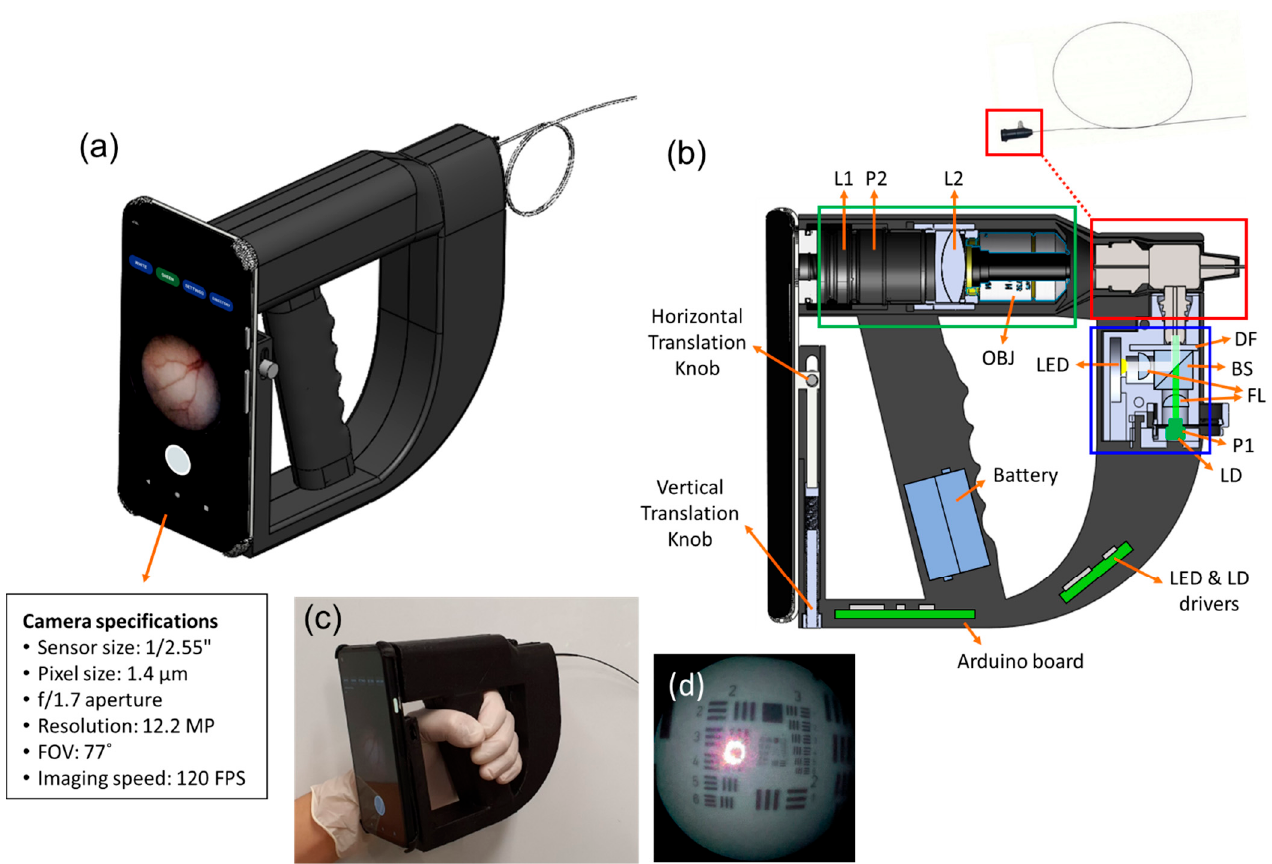
Figure 1. Implementation of a smartphone-based portable LSCI endoscope device: ( a ) A 3D model of a smartphone-based hand-held LSCI endoscope device and a schematic of its interior; ( b ) an image showing the light source module (blue box), fiberscope (red box), and lens unit (green box). L#: lenses, P#: linear polarizers, OBJ: objective, DF: diffuser, BS: beam splitter, FL: focusing lens, LD: